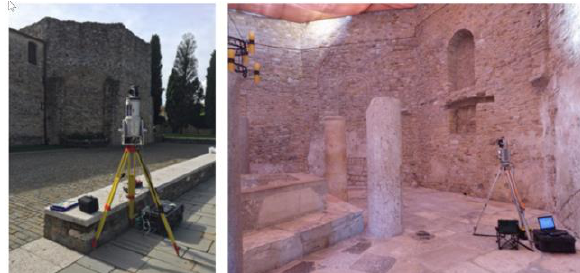
Figure 2. Acquisition of outside (left) and inside (right) using